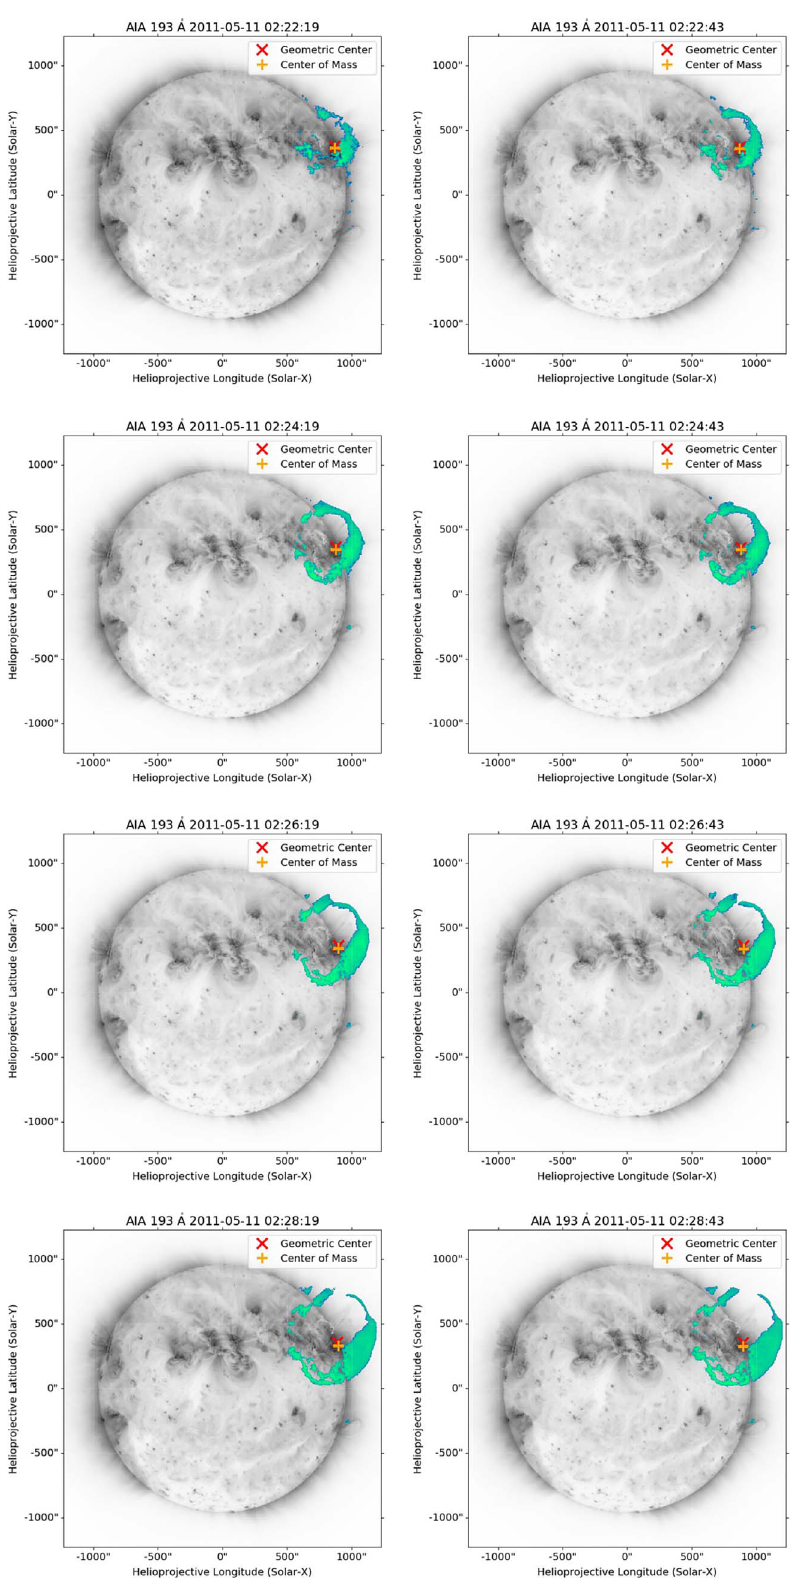
Fig. 7. The wavetrack output for four pairs of consecutive images separated by 2 min during the eruption of May 11, 2011, with the applied CBF mask, similar to Figure